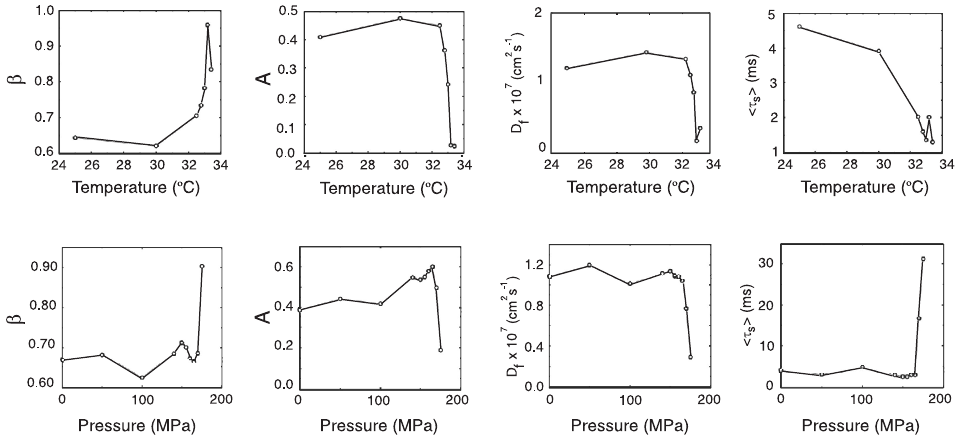
Figure 2. The time-intensity correlation functions of dynamic light scattering measurement of aqueous solutions of poly(N-isopropylacrylamide) (pNIPAM) at various temperatures and 0.1 MPa (A) and at various pressures and 25 º C (B). [pNIPAM] = 1%.